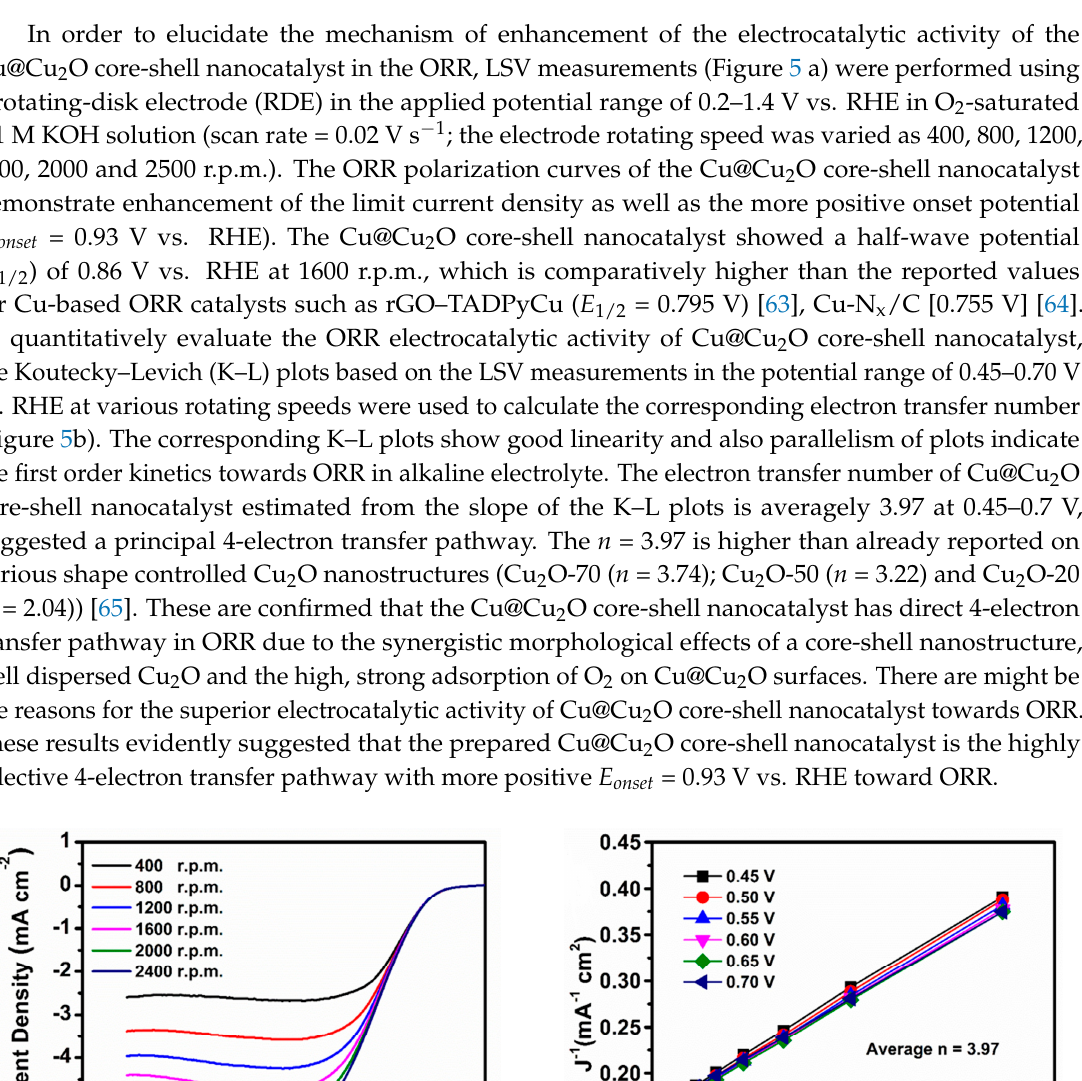
Figure 5. ( a ) Steady-state voltammograms of the ORR profiles at different rotation rates (400–2400 r.p.m.) and ( b ) Koutecky–Levich (K–L) plots of Cu@Cu 2 O core-shell nanocatalyst in and ( b ) Koutecky–Levich (K–L) plots of Cu@Cu 2 O core-shell nanocatalyst in O 2 -saturated 0.1 M KOH O 2 -saturated 0.1 M KOH solution with a scan rate of 0.02 V s − 1 . solution with a scan rate of 0.02 V s − 1